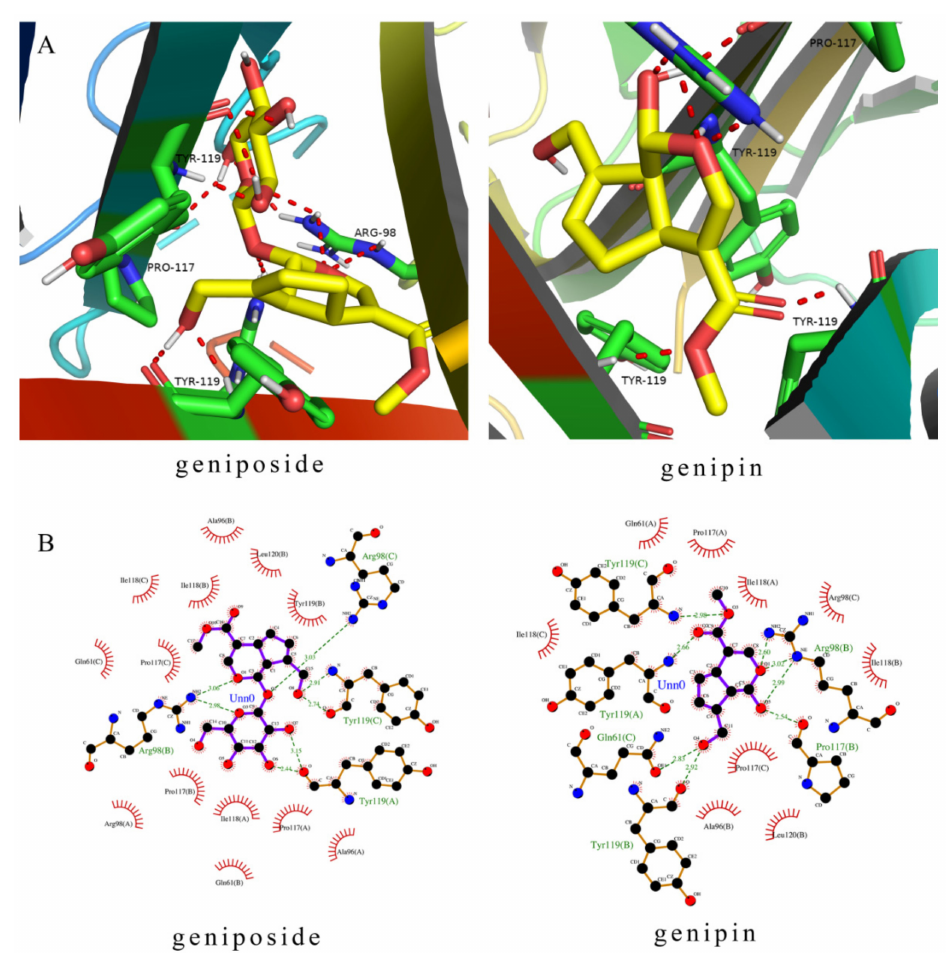
Figure 8. Molecular docking of the geniposide and genipin with TNFR1. ( A ) Molecular ligands are shown in stick form and red dashed lines were hydrogen. ( B ) Two-dimensional (2D) representation of hydrogen bonding and hydrophobic